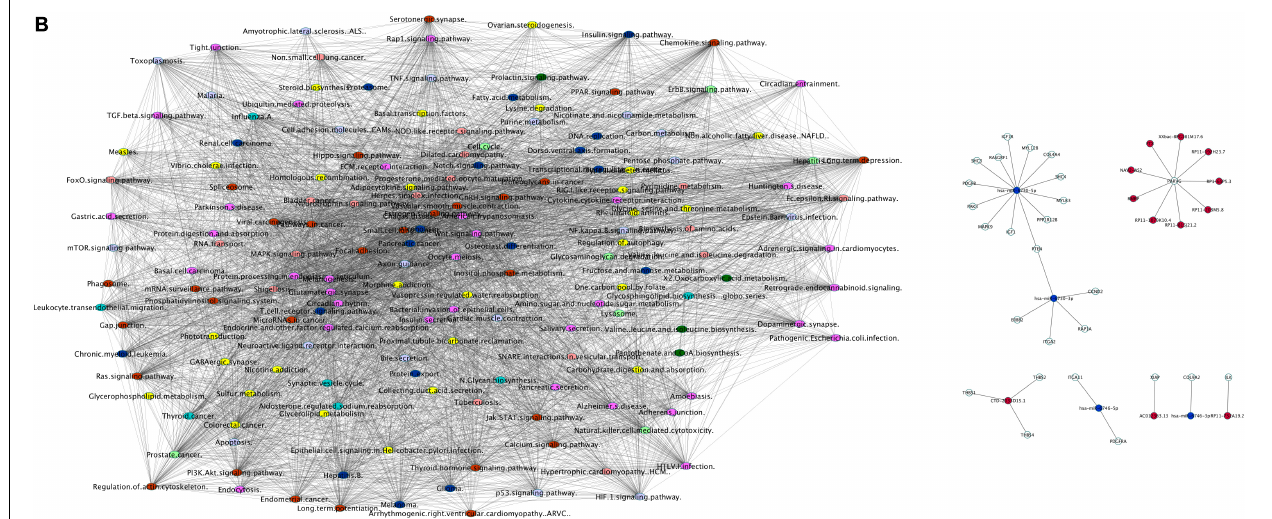
FIGURE 9 | Global network of interactions modulated by γ -valerolactones treatment in human brain microvascular endothelial cells and their relation with endothelial function pathways. (A) The total interactions between mRNAs, miRNAs, and targets, lncRNAs and targets and protein-protein interactions were used to build a network with Cytoscape software. Nodes colored labels. Red-lncRNAs, blue marine-miRNAs, green-miRNAs targets and mRNAs DE, pink-lncRNA targets and mRNA DE, yellow-lncRNA and miRNA targets and mRNA no DE, purple-mRNAs DE, blue clair-proteins and mRNAs no DE, black-miRNA and lncRNA target and mRNA DE, clair green-proteins and mRNA no DE and regulated by miRNA or lncRNA, olive-TFs, white- components not belonging to any of the previous color categories. DE, differentially expressed. Hubs network components are highlighted by bigger squares. (B) mRNA, miRNA targets, lncRNA targets and proteins were used to perform global GeneTrial enrichment analysis and obtained the pathways related. A pathway-connections network was built in Cytoscape. Node colored labels represent the omic layers (mRNA, miRNA targets, mRNA targets, proteins or combinations) from which the pathways were enriched. Yellow-miRNA, green-proteins, pink-mRNA + lncRNA + miRNA, blue marine-miRNA + proteins, clair blue-mRNA + miRNAs, clair purple-lncRNA + miRNA, red-mRNA + miRNA + lncRNA + proteins, melon-lncRNA + miRNA + proteins, clair green-mRNA + miRNA + proteins. (C) Small network of focal adhesion components and regulated by miRNAs and lncRNAS differentially expressed in our VALs vs. TNF- α groups